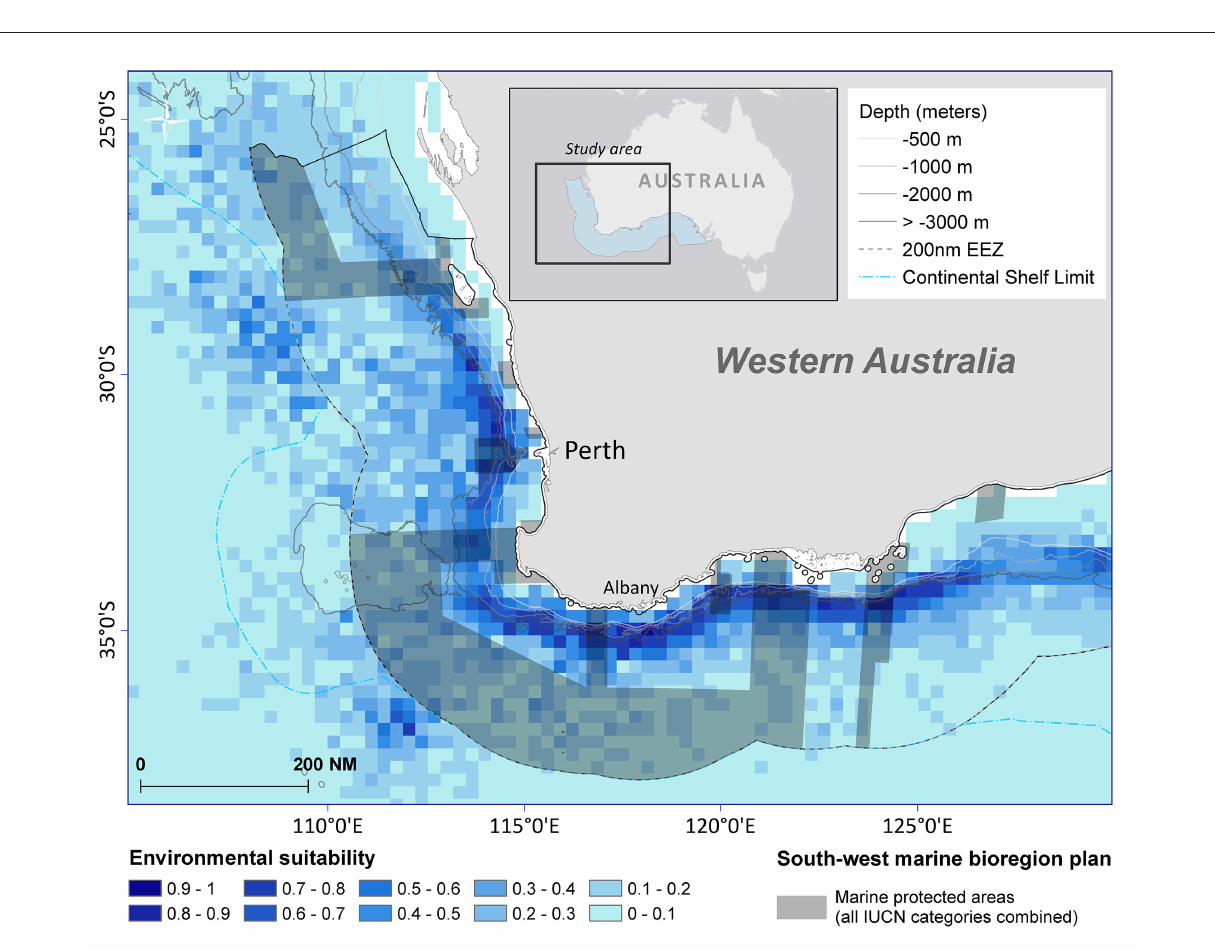
Frontiers in Marine Science |